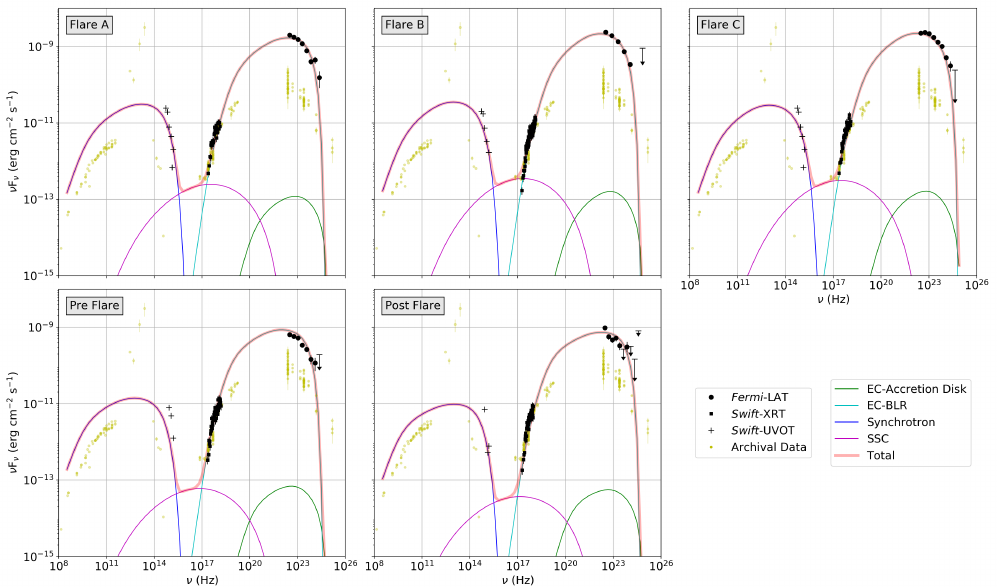
Figure 3. MWL emission of PKS 1830-211 in different flux states, modeled with GAMERA. The high- energy component of the FSRQ emission is described with a combination of SSC and EC scattering on anisotropic photon fields: disk (green line) and BLR (blue line), dominating. Figure from [42] reproduced with permission of the authors and IOPPublishing.